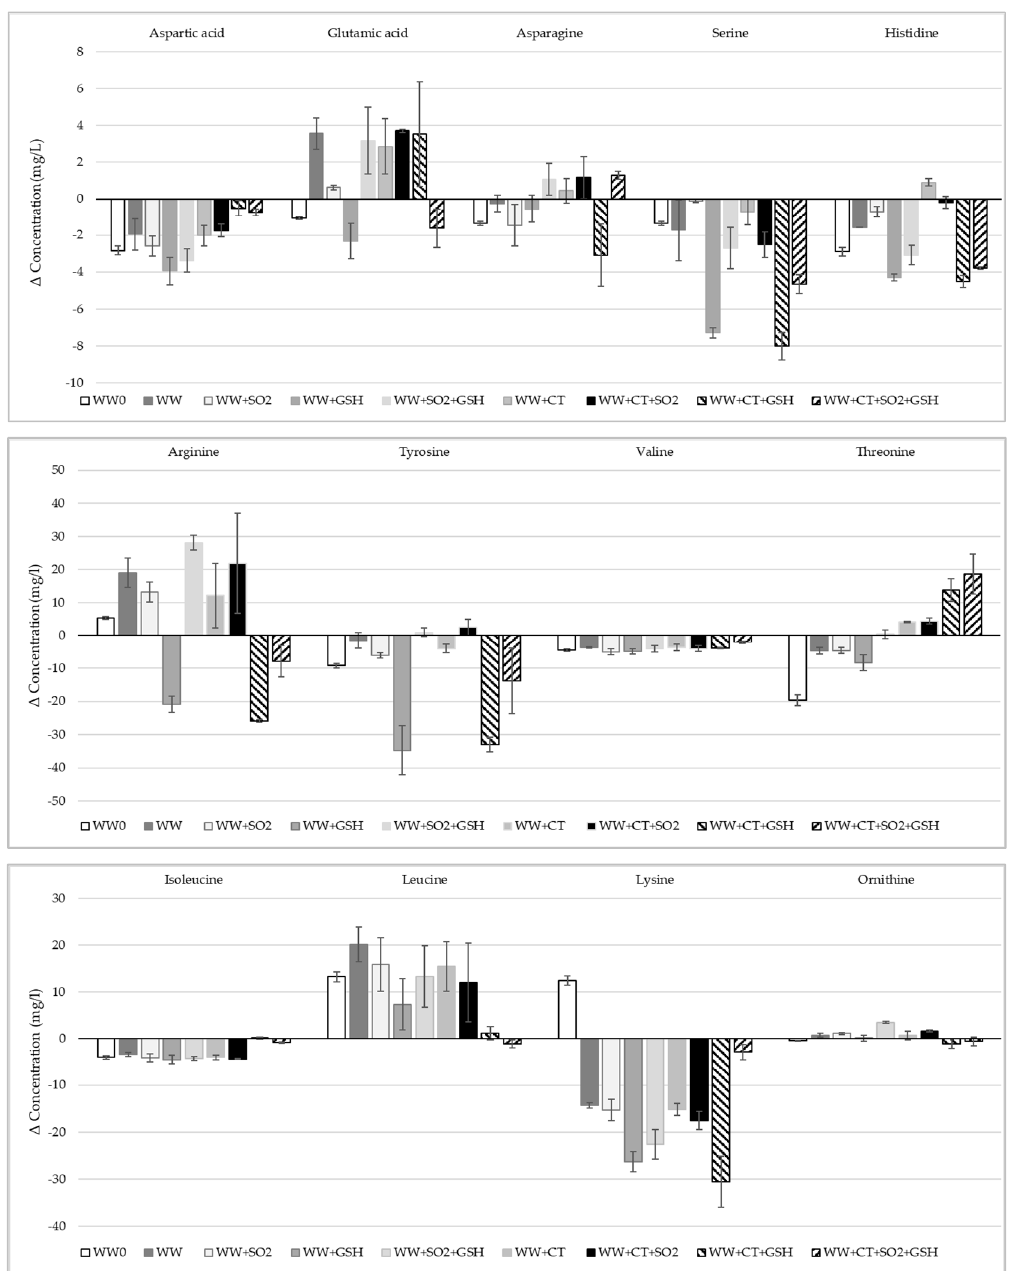
Figure A1 . Differences of the amino acid concentrations between the white Figure A1. Differences of the amino acid concentrations between the white wine (WW) samples without light exposure wine (WW) samples without light exposure and the corresponding WW and the corresponding WW samples with light exposure. For samples coding, see Table 6. Data are not shown for alanine, samples with light exposure. glutamine and phenylalanine as negligible differences were